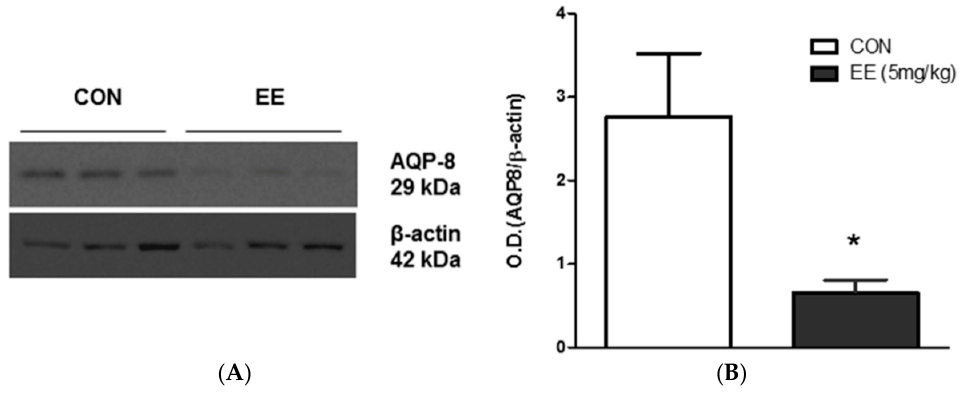
Figure 2. ( A ) AQP8 protein expression in the liver of untreated (CON, control animals receiving propylene glycol as drug vehicle, s.c.) and cholestatic mice (EE). Cholestasis was induced by ethinyl estradiol (5 mg/kg/die for five days, s.c.). Male 10-week-old BALB/c mice were killed at day 5, 1